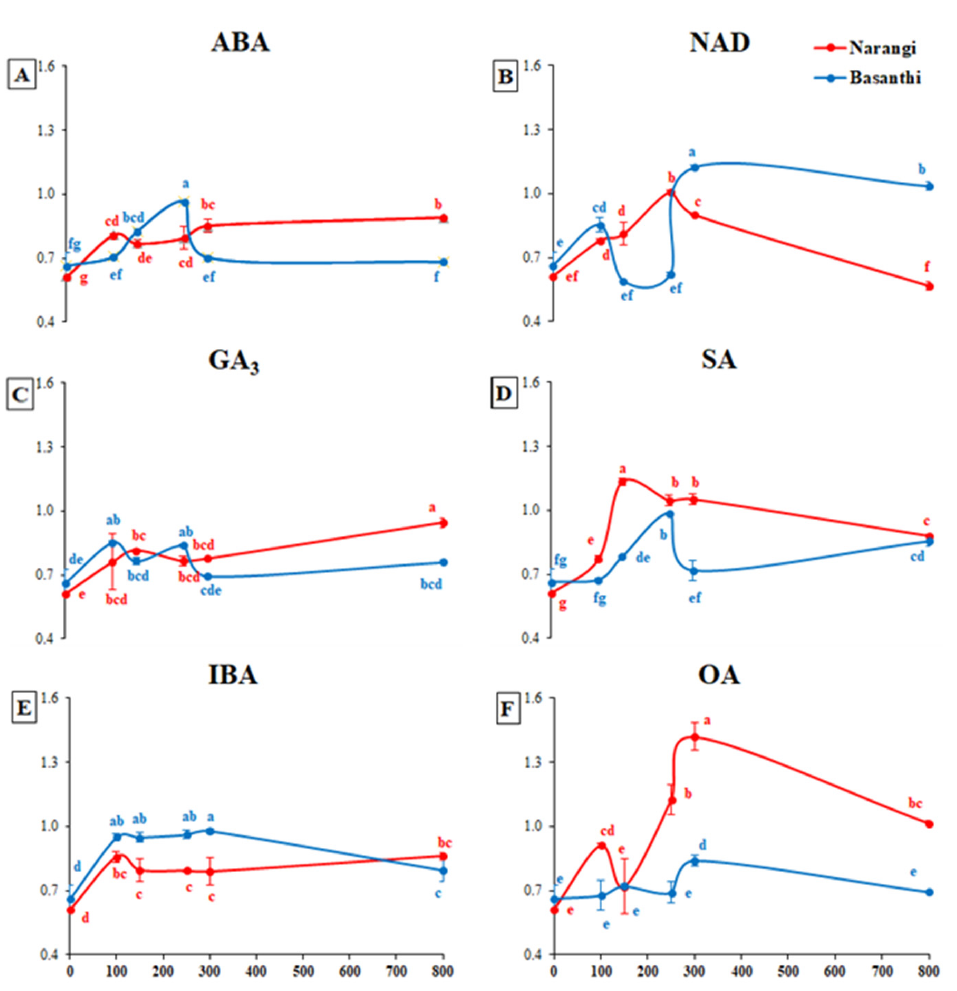
Figure 4. Flower dry weight (g) of two cultivars of marigold (“Pusa Narangi Gainda” and “Pusa Basanthi Gainda”) as affected by different doses (mg · L − 1 ) of ABA ( A ); NAD ( B ); GA 3 ( C ); SA ( D ); IBA ( E ) and OA ( F ). Same letters indicate non-significant difference among treatments under Fisher’s least significant difference test ( p ≤ 0.05). Vertical bars indicate average ± standard error (three replications, under bi-factorial